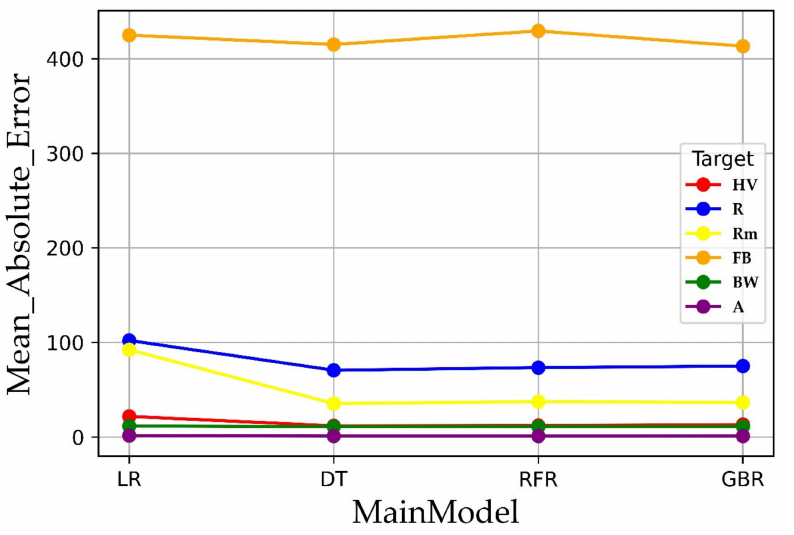
Figure 15. Evaluation the performance of the utilized ML approaches to the experimental data using